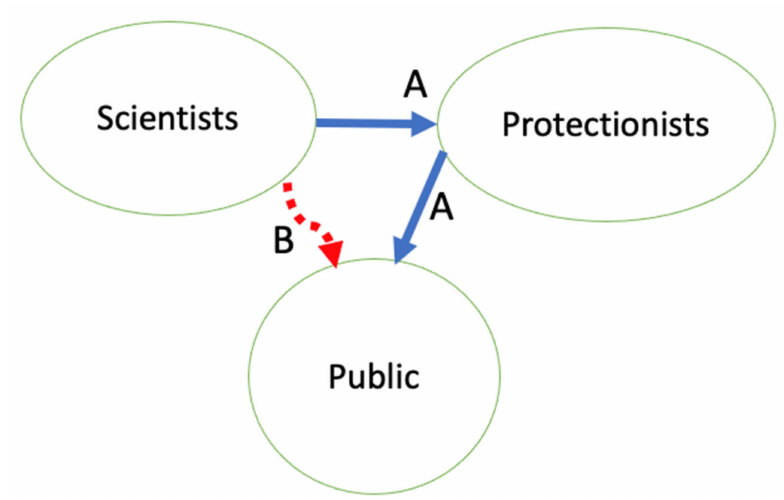
Figure 2. Animal-use information flow, as perceived by some protectionists. ( A ) Protectionists obtain information from science and scientists and to pass on to the public. ( B ) Scientists bypass communication with protectionists and release partial and misleading information about animals.